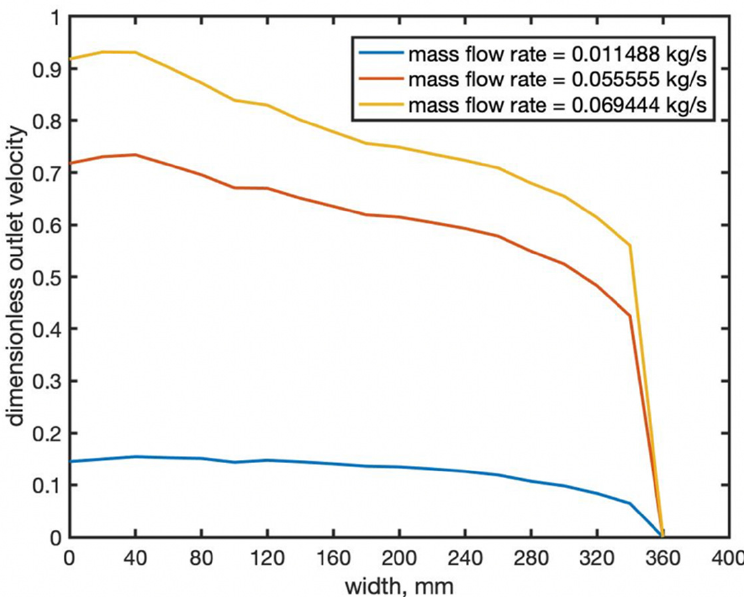
Figure 4. Outlet velocity distribution with changing mass flow rate.